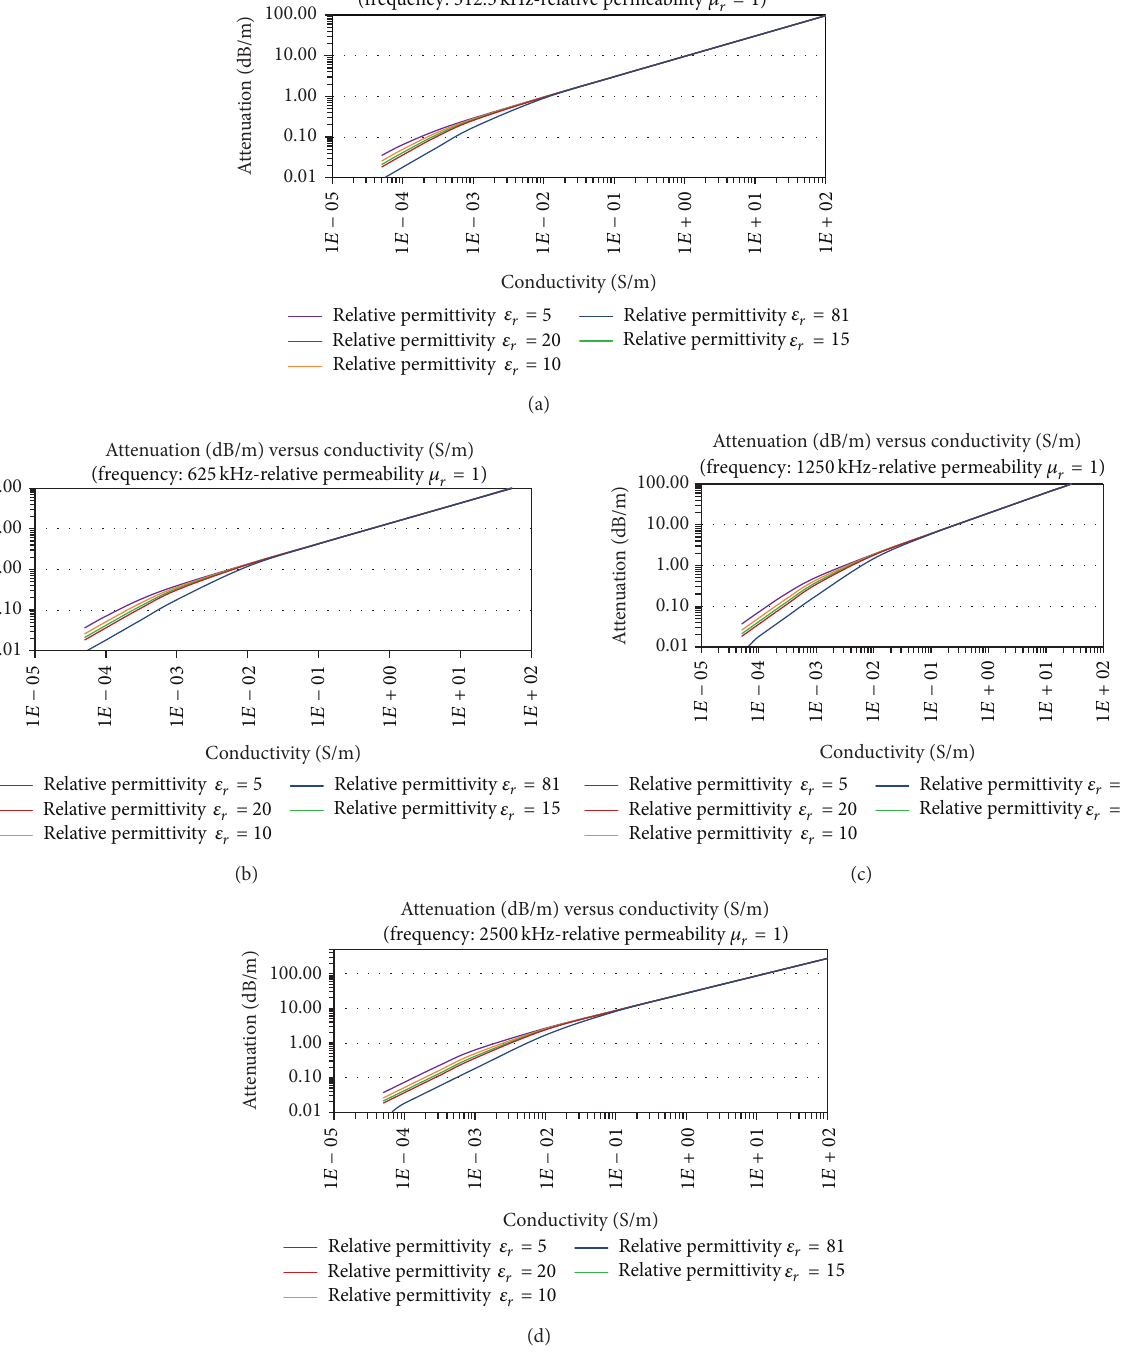
Figure 3: The attenuation presented as a function of conductivity in various materials. The relative permittivity ranges between 𝜀 𝑟 = 5 and = 81 (water). The relative permeability is fixed at the free space value (1). (a) Frequency 312.5 kHz, (b) frequency 625 kHz, (c) frequency 𝜀 𝑟 1250 kHz, and (d) frequency 2500